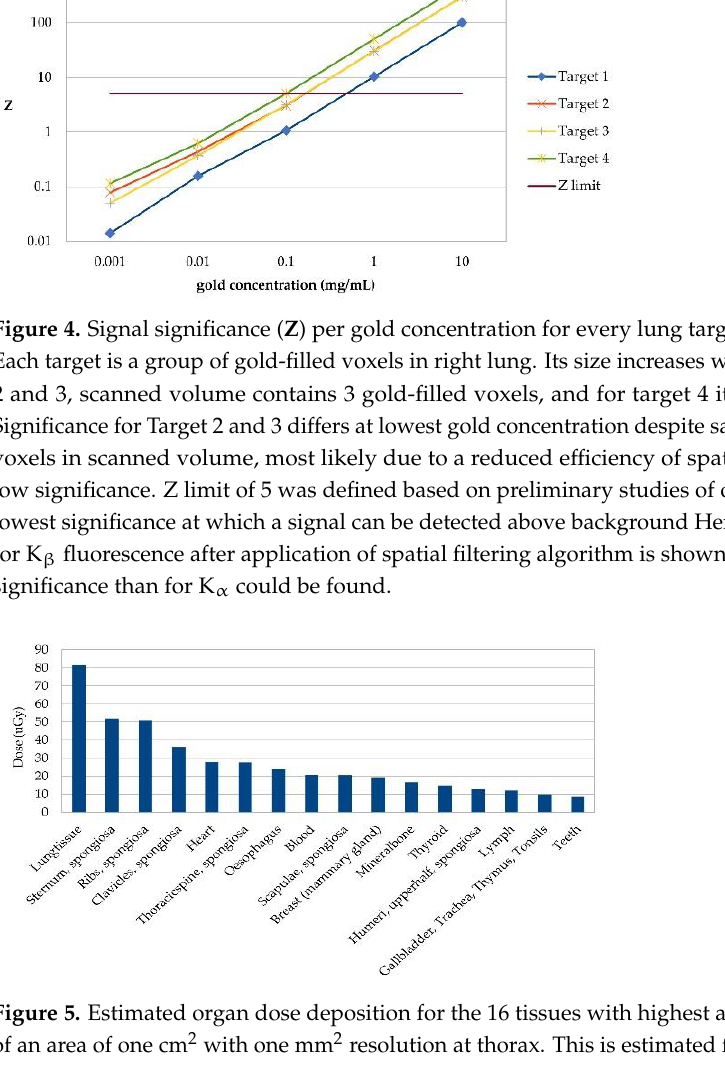
Figure 5. Estimated organ dose deposition for the 16 tissues with highest average dose for scanning of an area of one cm 2 with one mm 2 resolution at thorax. This is estimated for a total of 100 scanning positions, as doses are averaged over all scans with all gold concentrations and target sizes for one simulated scan point, and then multiplied by 100.